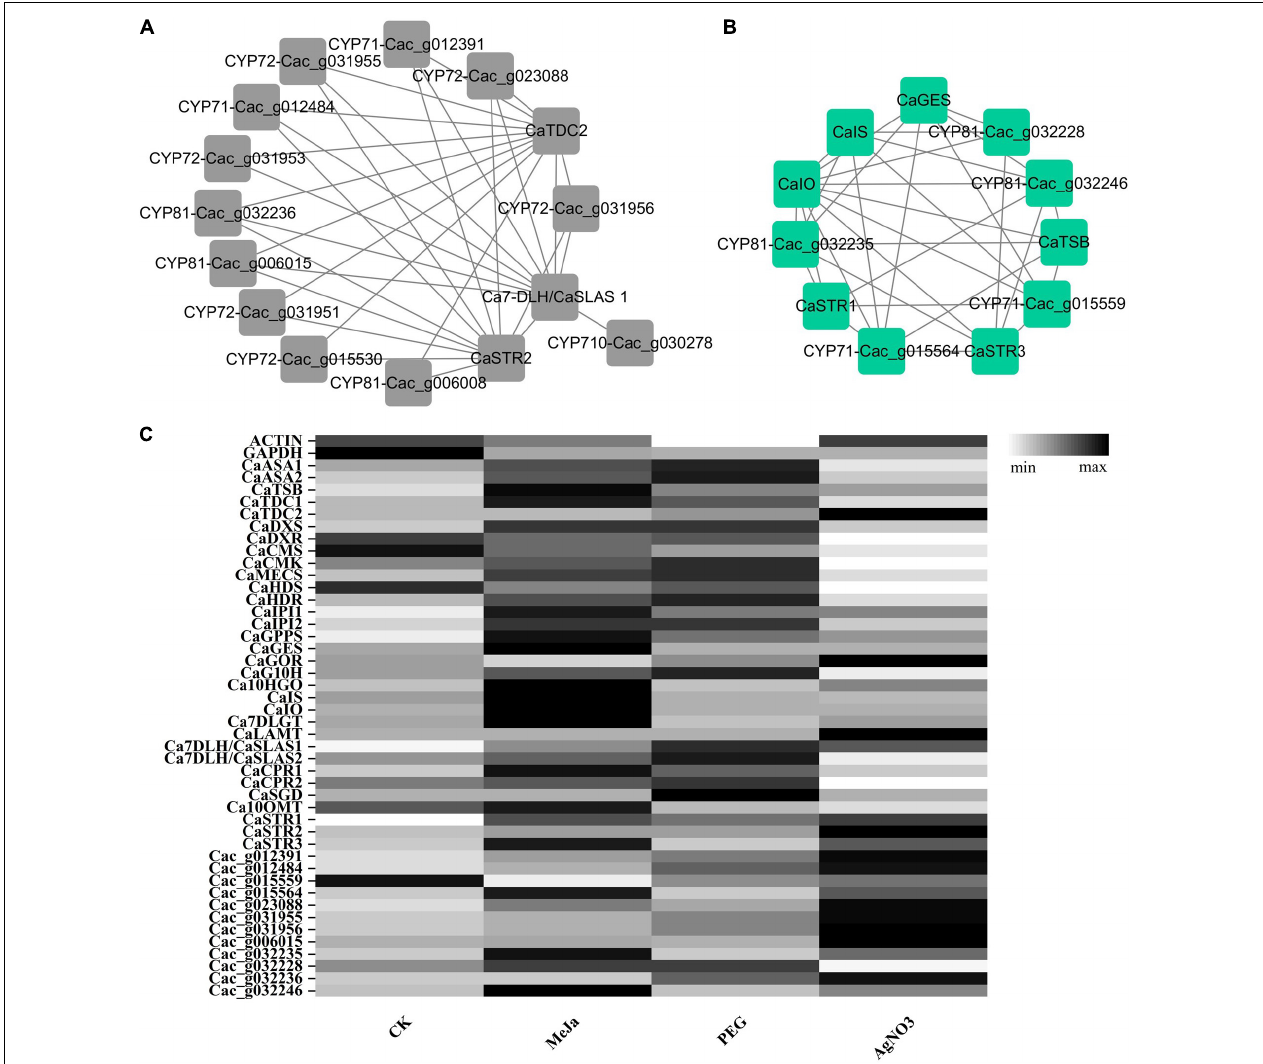
FIGURE 7 | The co-expression network and expression patterns of the newly mined CYP450s and previously characterized genes in C. acuminata . (A) The co-expression network of targeted genes in the black module. (B) The co-expression network of targeted genes in the green module. (C) The expression patterns of genes in different treatment